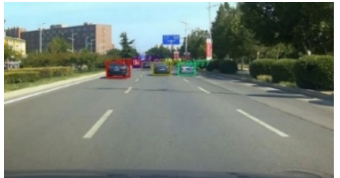
Figure 17. Detection results.